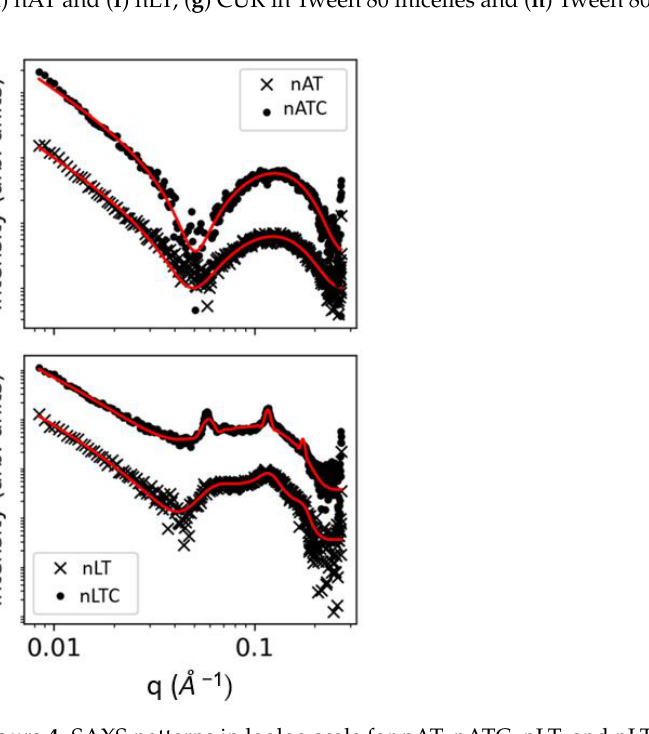
Figure 4. SAXS patterns in loglog scale for nAT, nATC, nLT, and nLTC systems.